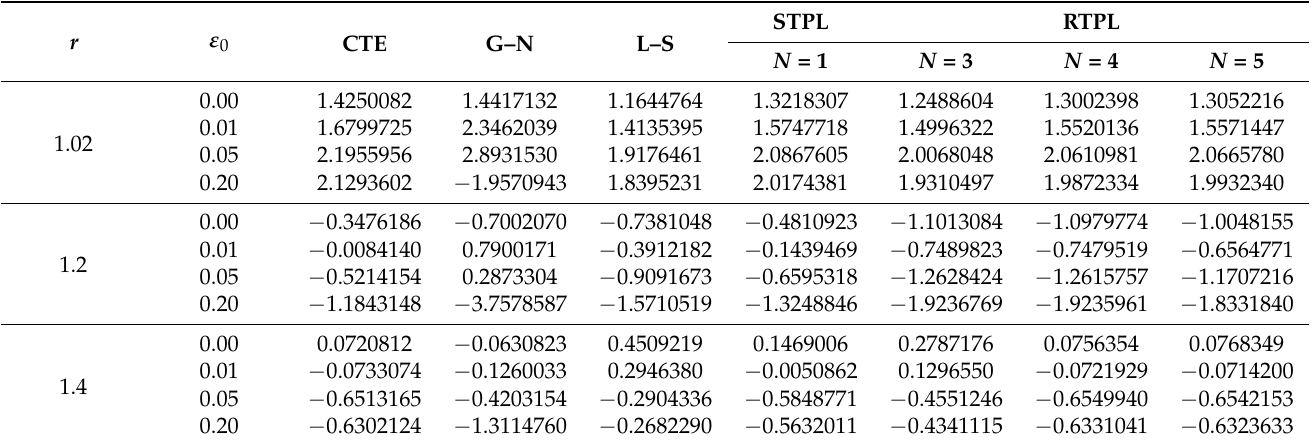
Table 14. Different thermoelasticity theories with a range of r values show the effects of dimensionless electric permittivity ε 0 on radial stress σ rr .